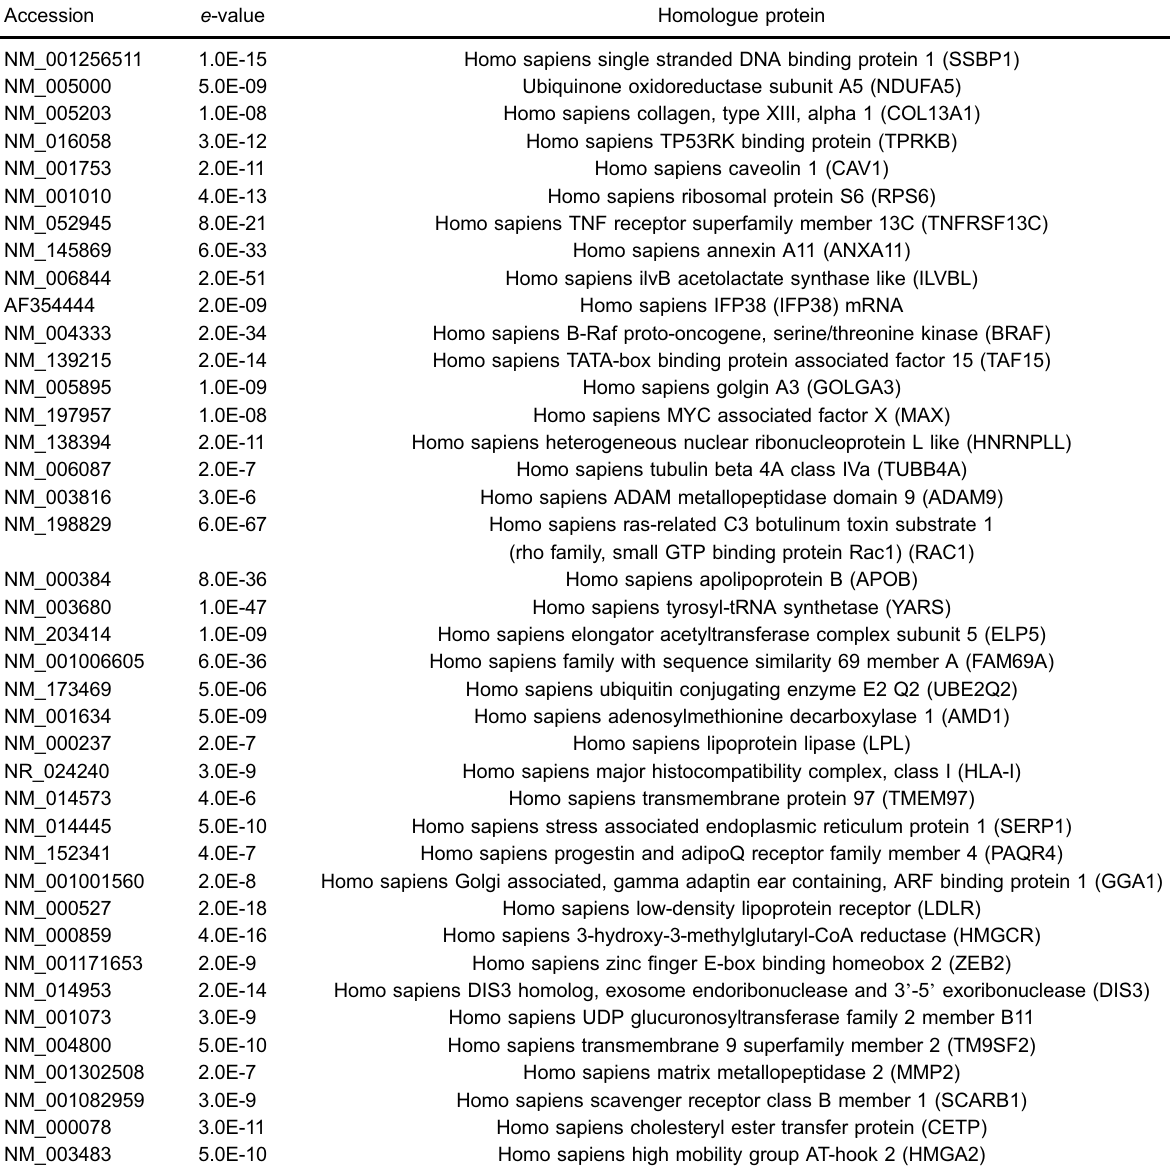
Table 1. Transcripts that showed high homology to known